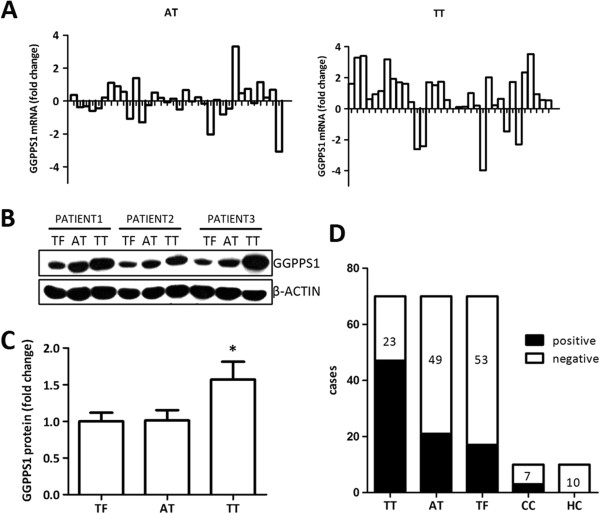
Expression of GGPPS1 in liver tissues and tumor tissues of the patients with hepatocellular carcinoma. (A) Relative expression level of GGPPS1 mRNA in 34 paired adjacent nonmalignant (AT) and tumor tissues (TT) comparing with tumor-free (TF) by qRT-PCR. Logarithm of fold change is shown. (B) Representative western blots analysis of GGPPS1 expression in 15 paired TF, AT and TT. (C) Semiquantitative western blots analysis of lysates of 15 paired tissue samples is shown. The mean protein expression level was significantly increased in TT compared with TF. (D) Immunohistochemical staining of anti-GGPPS1 antibody in paired AT and TT (n = 70), cirrhotic liver as cirrhosis control (CC, n = 10), and normal liver as healthy control (HC, n = 10) is shown.